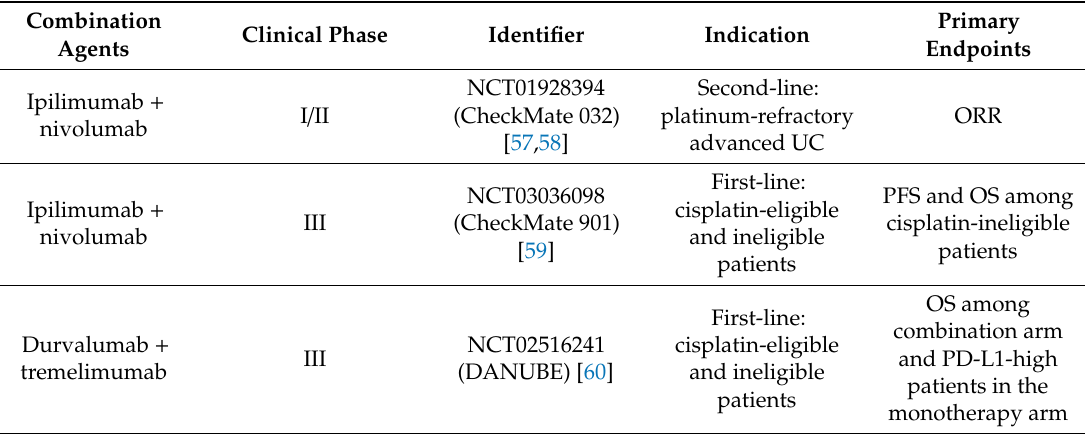
Table 4. Ongoing trials evaluating a combination of immunotherapies for urothelial